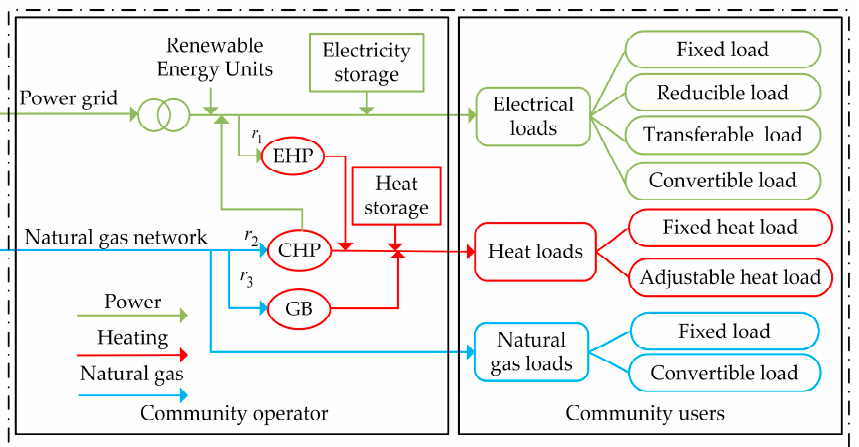
Figure 1. Community Integrated Energy System Model.